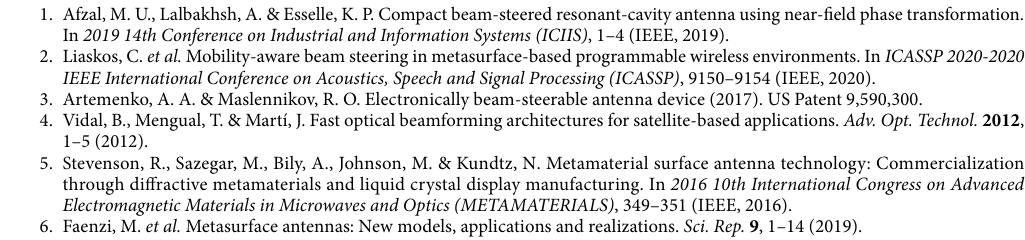
Figure 20. Simulated and measured elevation plane pattern cuts for the case when lower PGM is fixed 0 ( ψ 1 ◦ ) and upper PGM is rotated ( ψ 2 is varied) from = 150 120 90 ψ 2 ◦ , ( c ) ψ 2 = ◦ ( d ) ψ 2 = ◦ and ( e ) ψ 2 = = pattern